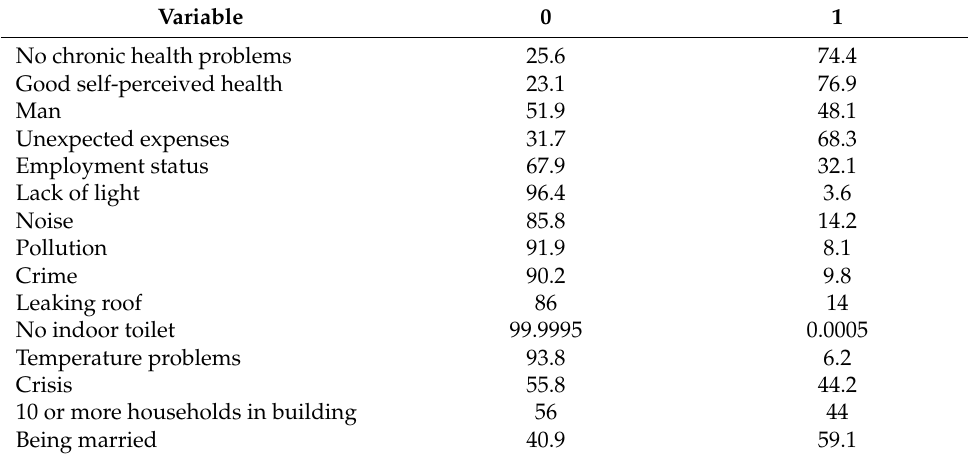
Table 1. Frequencies associated with dichotomous